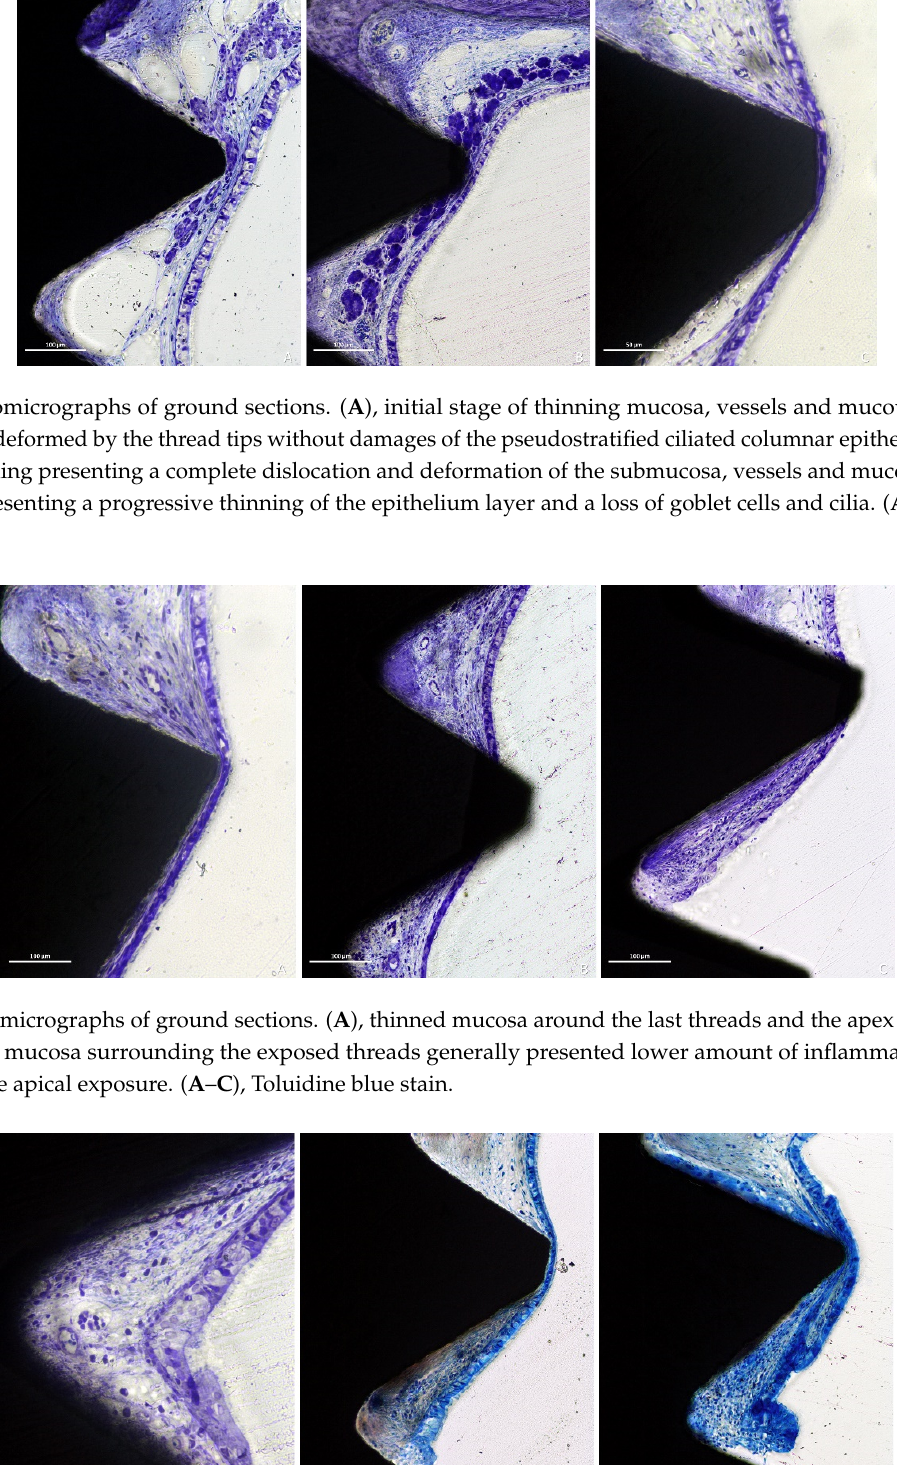
Figure 9. Photomicrographs of ground sections. Repairing tentative to close the exposed submucosa layers was seen performed by the epithelial cells ( A , B ), often associated with a hyperfunction of the goblet cells ( A ). The epithelium was also found enfolding coronally underneath the adjacent mucosa ( C ). ( A ), Toluidine blue stain. ( B , C ), Stevenel’s blue and Alizarin red stain.